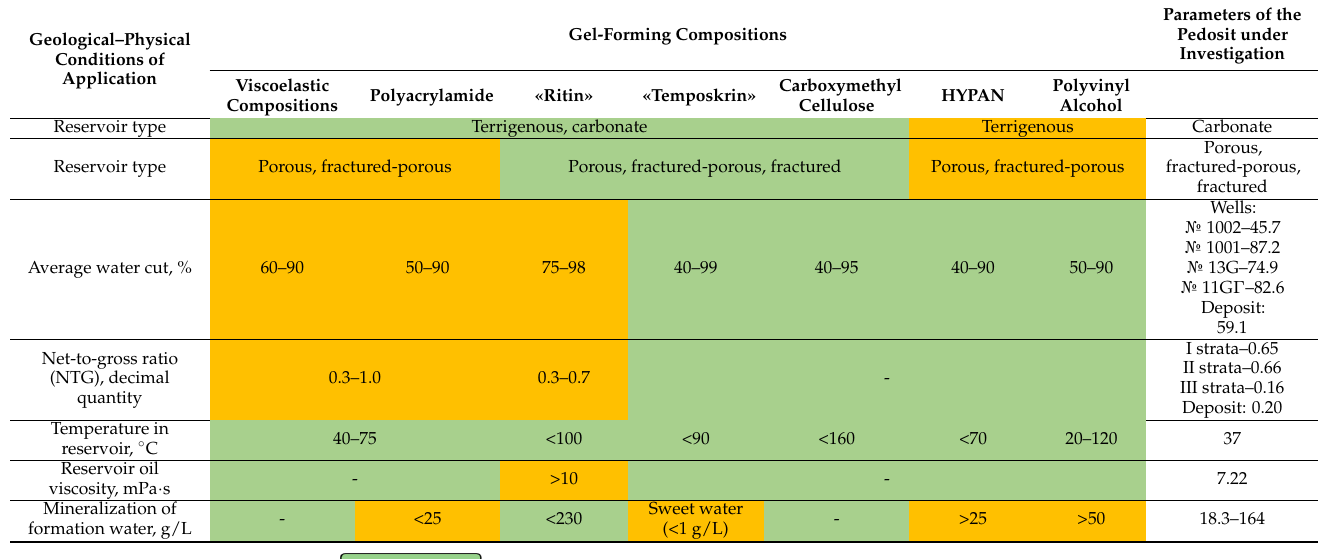
Table 1. Matrix of applicability of water shut-off technologies considering the main geological, physical, and field parameters. Compiled by the authors. Table 2. Matrix of applicability gel-forming compositions for water shut-off taking into account the main geological, physical, and field parameters. Compiled by the authors.